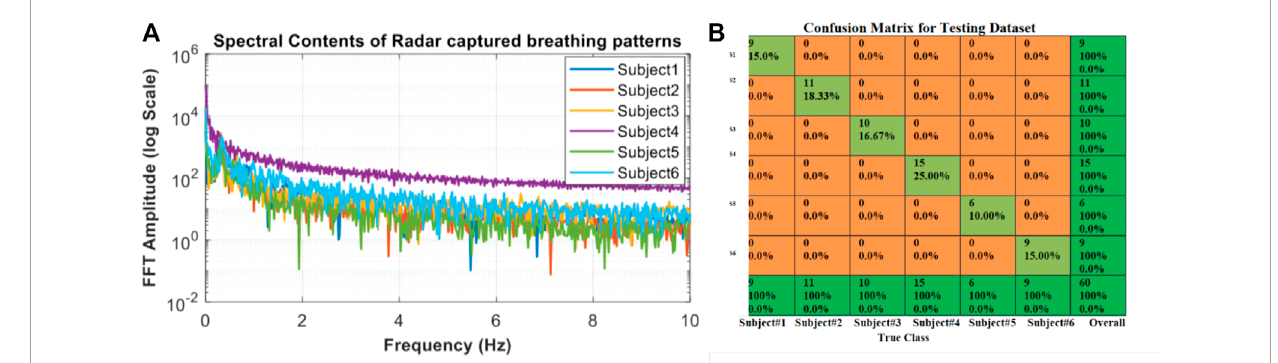
FIGURE 9 Spectral respiratory feature extraction used with SVM classification to identify six subjects. Based on the FFT for six participants (A) , SVM classification was used to produce 100% accurate identification of each subject, as shown in the confusion matrix (B) (Islam et al.,